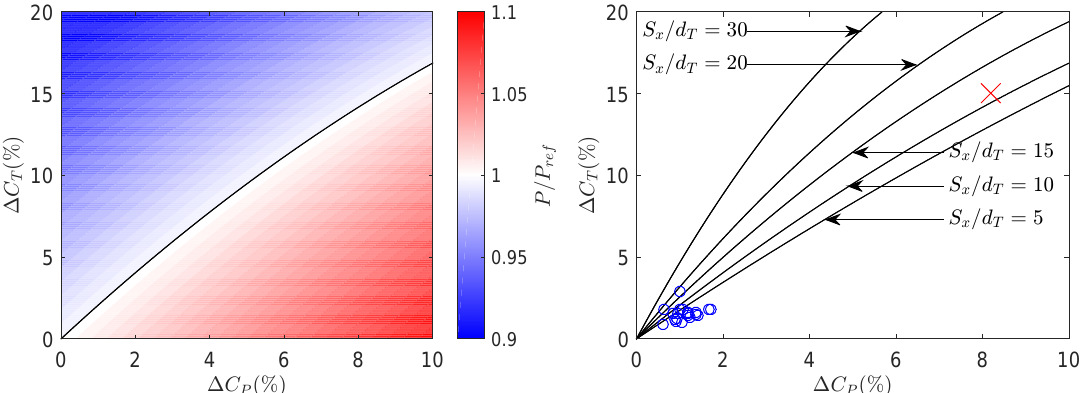
Figure 5. Illustration of maximum allowable increase in C Left: combined power output for given increase in C power, where inter-turbine spacing is 10 rotor diameters. Right: break-even lines for several inter-turbine spacings. Red crosses come from this experiment. Blue circles are